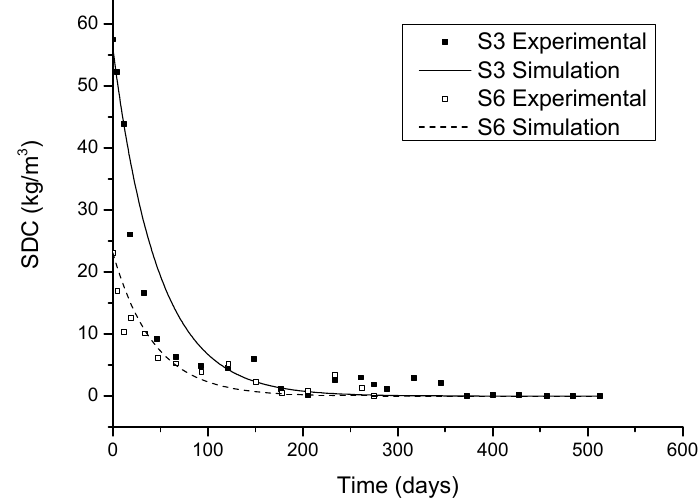
Figure 5. Time profiles of SDC degradation (experimental data cited in [35]). Ammonia nitrogen concentration rapidly degraded to a very low level within 2 months (~60 days), after which it decreased slowly. Ammonia nitrogen started SND under ventila- tion and changed into nitrogen. The consumption cycle of ammonia nitrogen was roughly synchronized with SDC. The degradation rate of S6 was obviously faster than that of S3 (Figure 6).